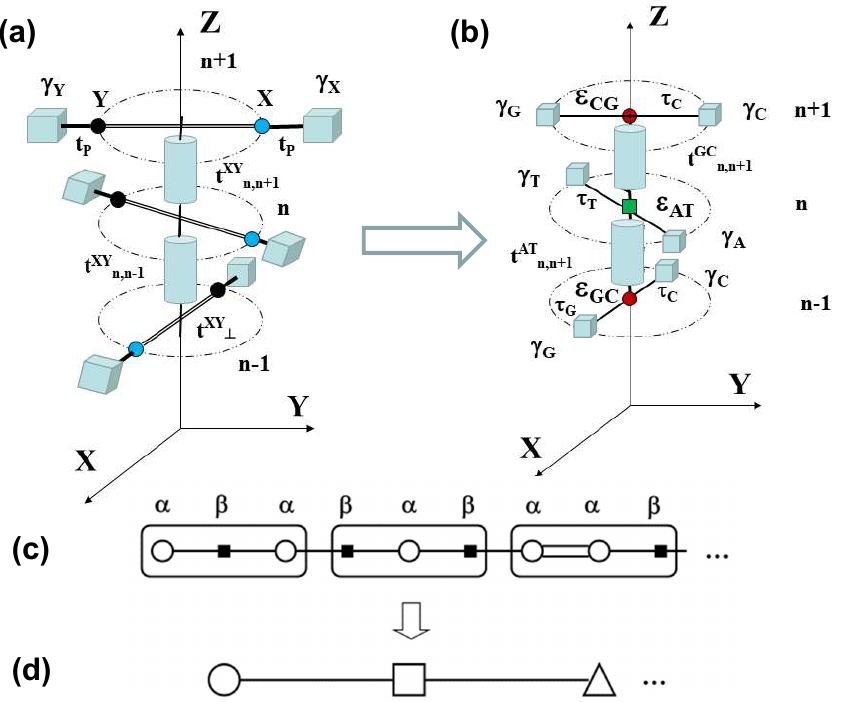
Figure 3. Sketch illustrating the three-step renormalization process mapping the 3D dsDNA electronic model shown in ( a ) into the 3D fishbone model shown in ( b ), then into the effective 1D diatomic and polyatomic lattice models displayed in ( c ) and ( d ), respectively, the latter corresponding to a chain made of codon triplets building blocks.